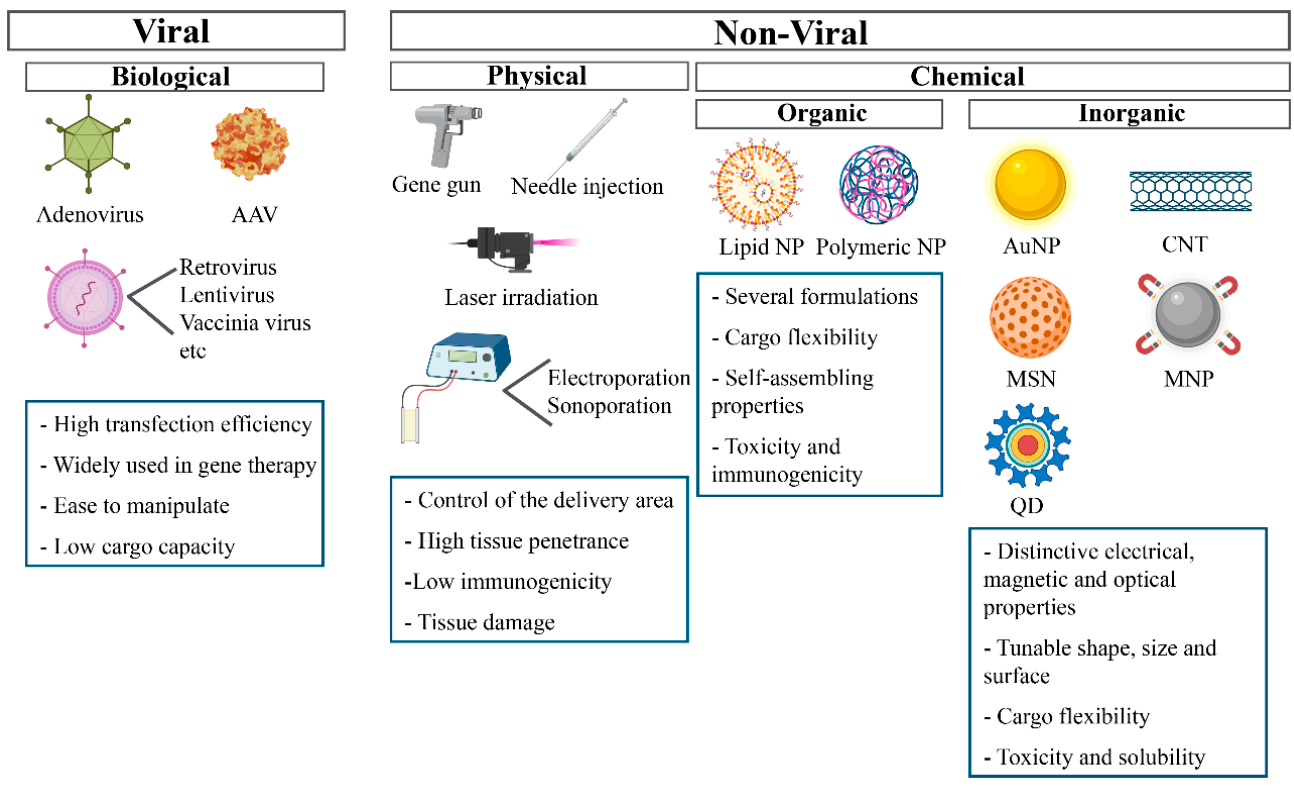
Figure 2. Representation of viral and non-viral delivery systems. AAV: adeno-associated virus. NP: nanoparticle. AuNP: gold nanoparticle. CNT: carbon nanotube. MNP: magnetic nanoparticle. MSN: mesoporous silica nanoparticle. QD: quantum dot.